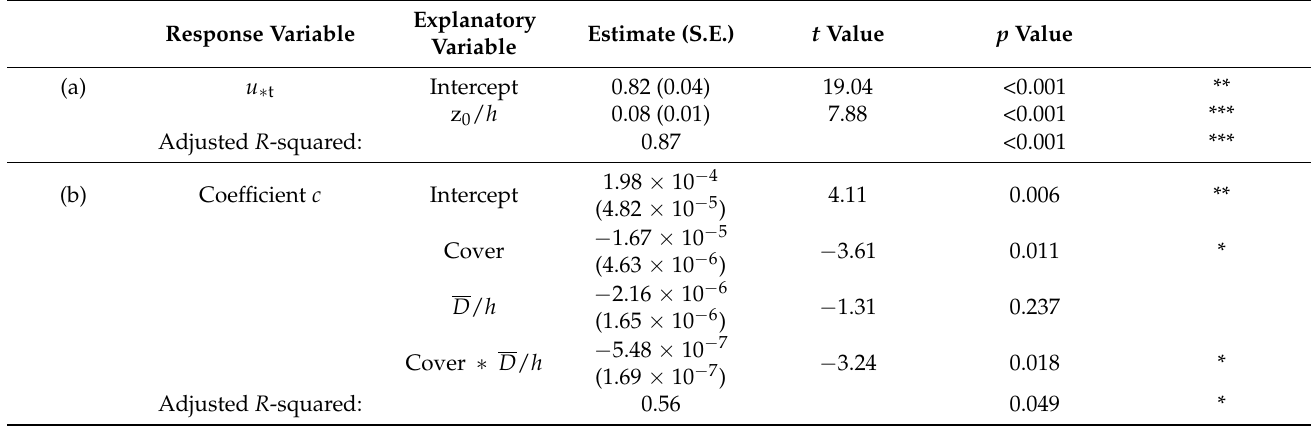
Table 2. Multiple linear regression